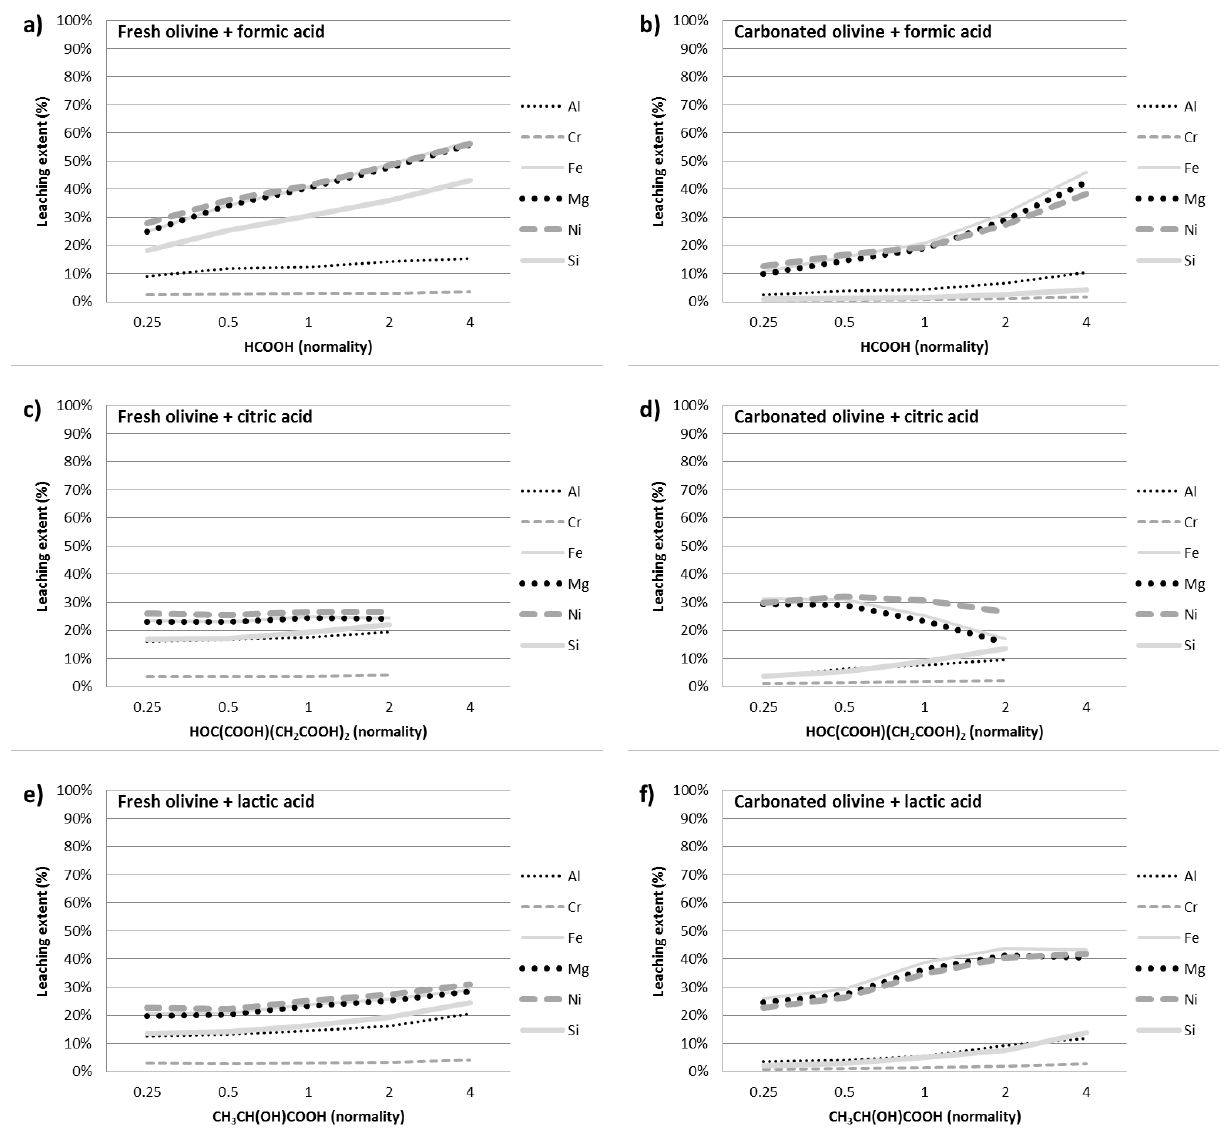
Figure 10. Leaching extent from fresh ( a , c , e ) and carbonated ( b , d , f ) olivine with formic ( a , b ), citric ( c , d ), and lactic ( e , f ) acids; Tables S4 and S5 provides statistical data on